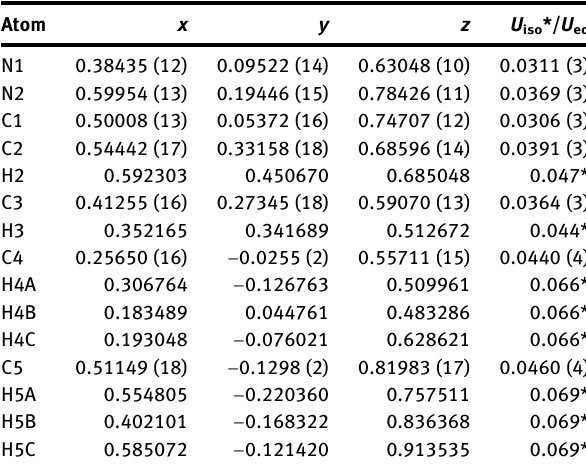
Table  : Fractional atomic coordinates and isotropic or equivalent isotropic displacement parameters (Å 